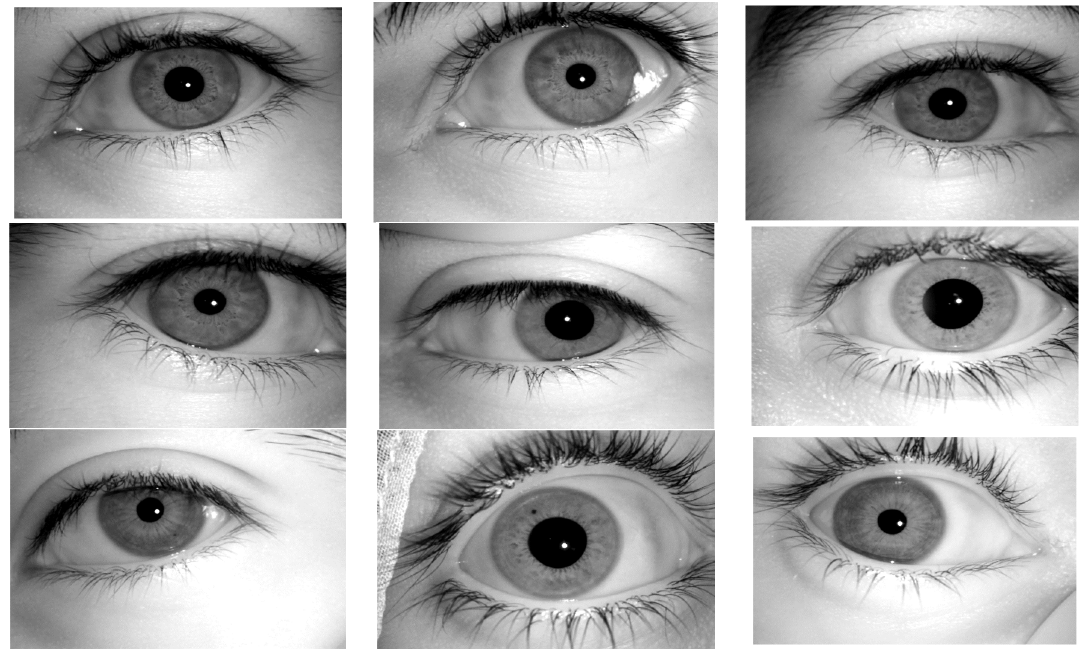
Figure 10. Iris images of different persons in our database.